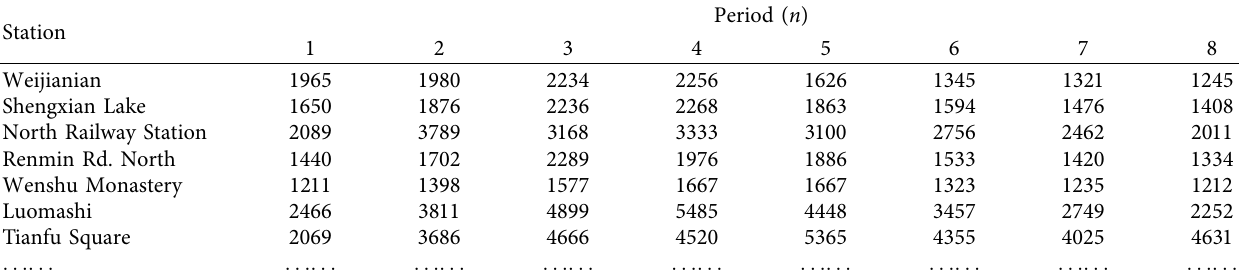
Table 3: Passenger inflows (persons) at stations of Line No. 1 (in part).